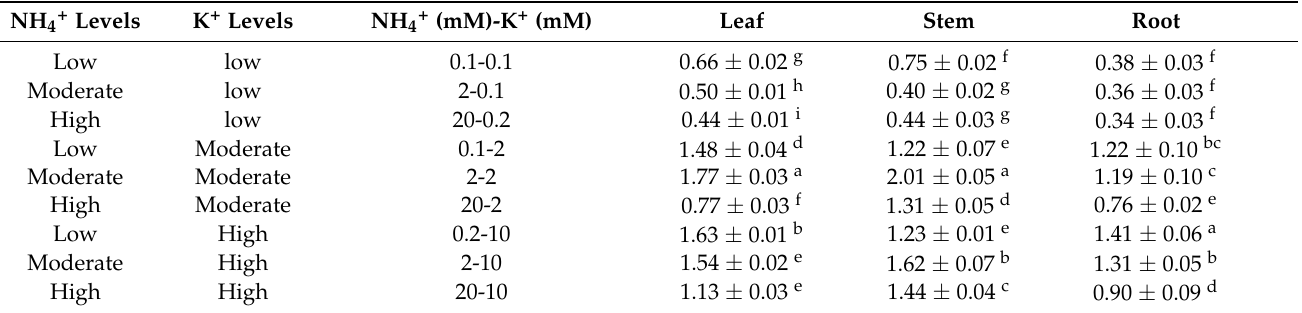
Table 3. Potassium concentrations (mmol g − 1 DW) in tobacco seedlings’ leaves, stems, and roots.